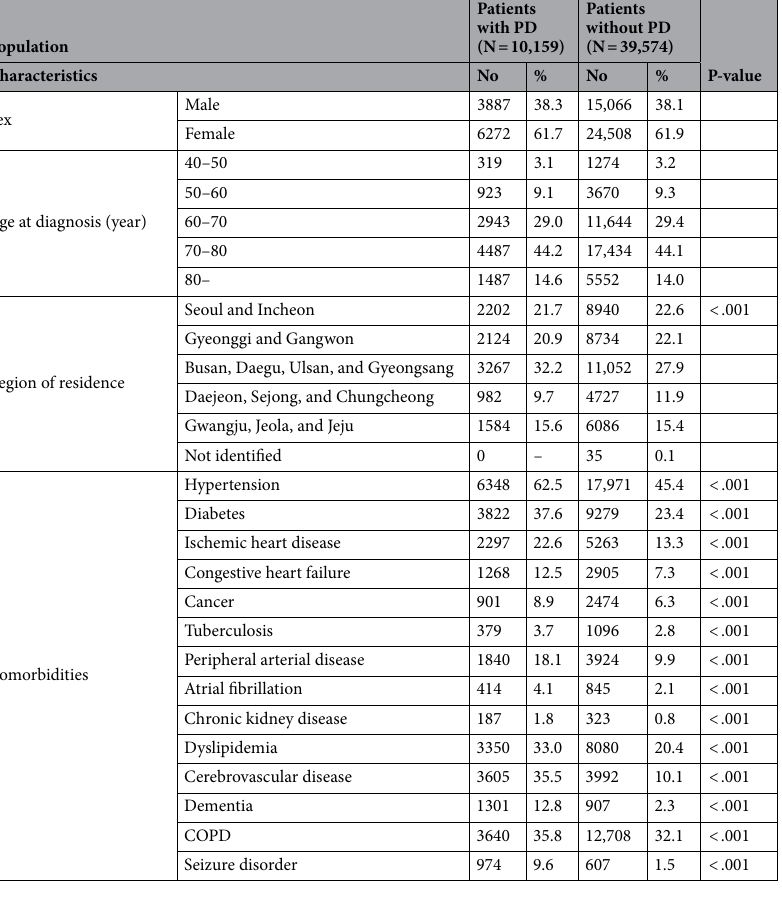
Table 1. Baseline characteristics of study population and control group. PD Parkinson’s disease, COPD chronic obstructive pulmonary disease. Charlson comorbidity index was included in the